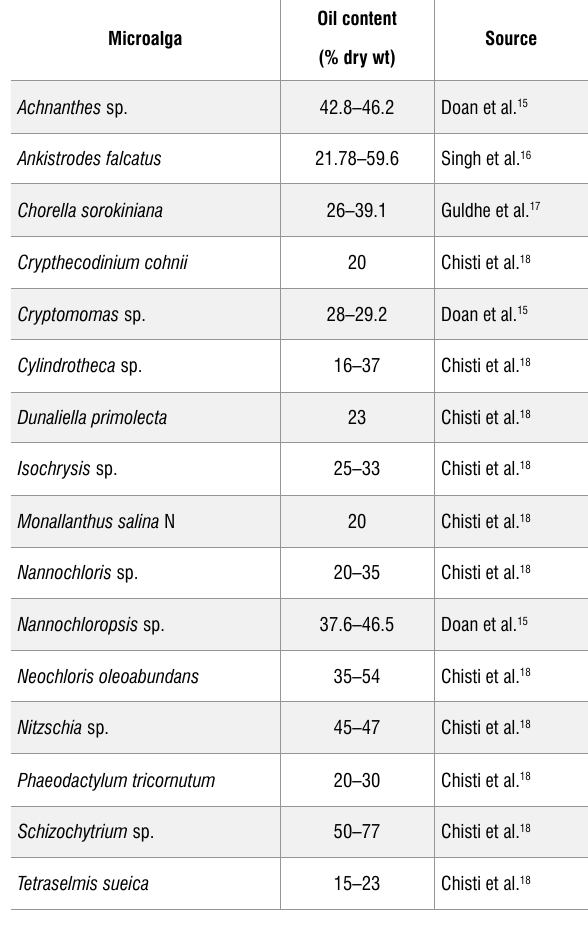
Average productivities of some common oilseed